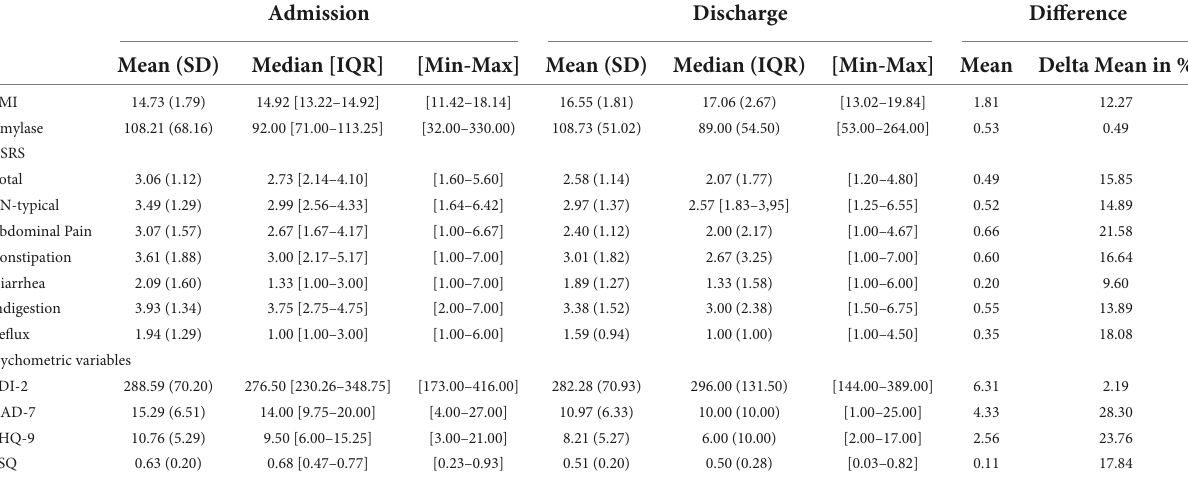
TABLE 1 Description of body mass index, serum amylase levels, gastrointestinal symptom rating scale scores, and psychometric variables at admission and